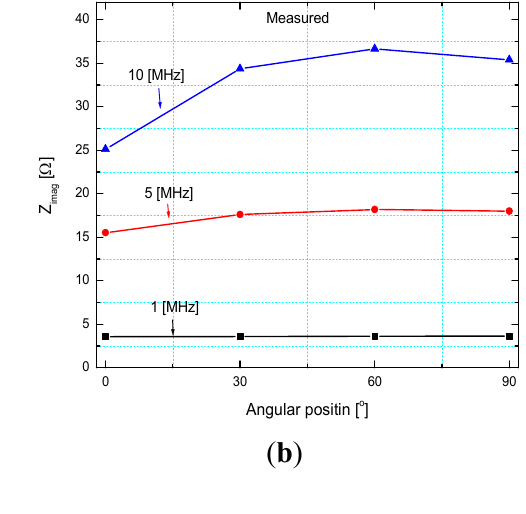
Figure 10. Measured ( a ) real part– Z with the short circuit at the rotor as a function of the angular